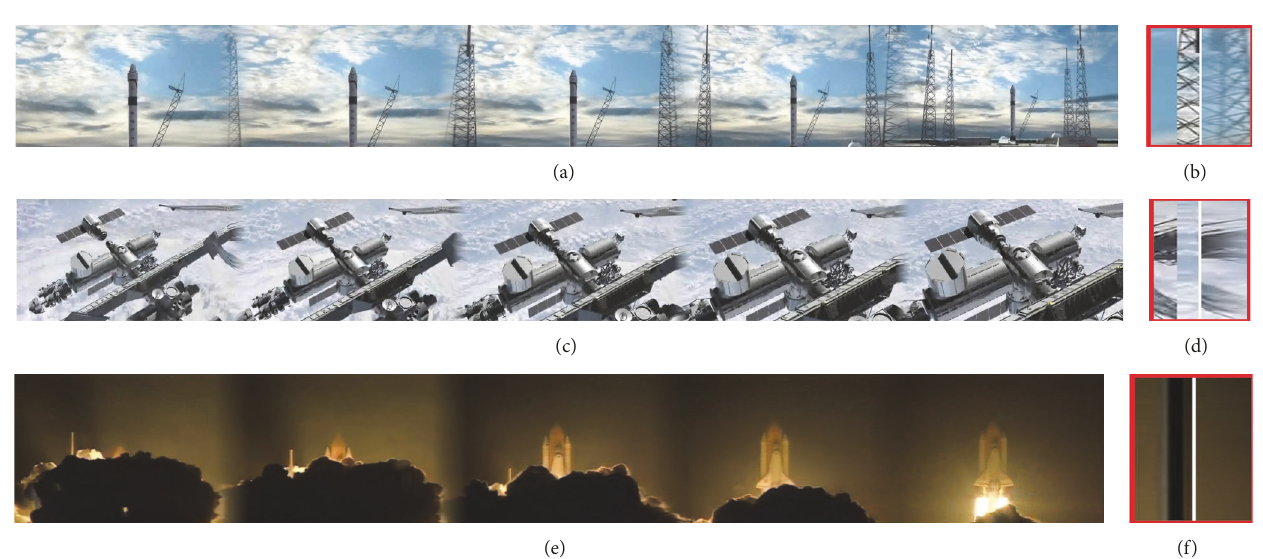
Figure 18: Space movement display for S3, S4, and